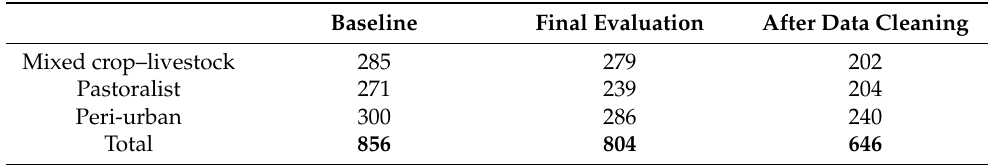
Table 12. Intervention-arm households enrolled at baseline, participating in the final evaluation, and remaining after data